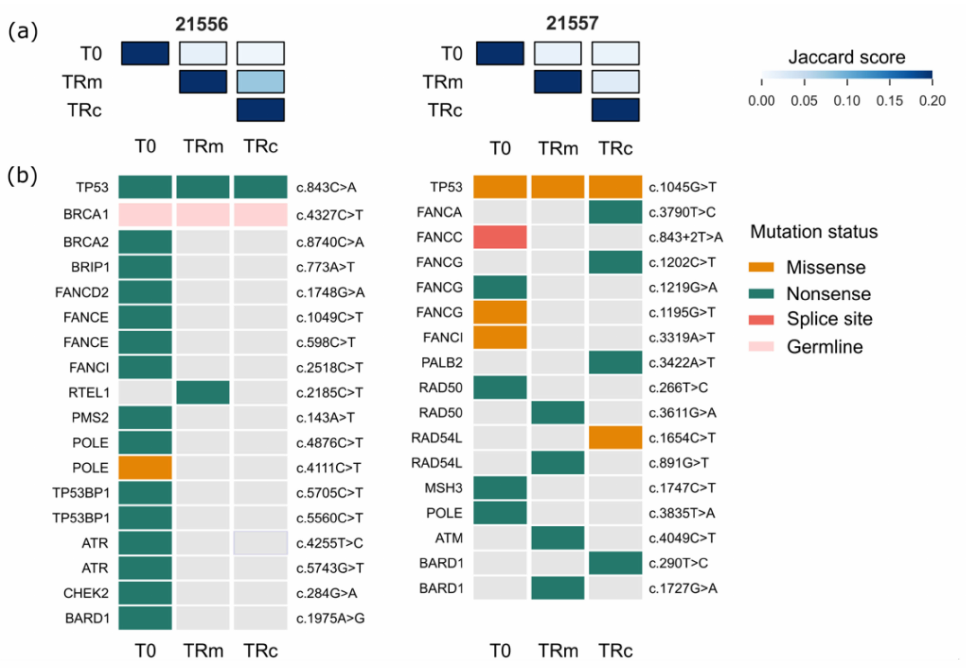
Figure 3. Genomic landscape evolution of SNVs in plasma samples. Jaccard similarity score ( a ) and oncoprints of pathogenic variants ( b ) for two representative cases (namely, 21556 and 21557) are reported. ( a ) The Jaccard similarity score is a numeric value indicating the level of similarity of sample pairs (see Section 2). Rows and columns report the name of the samples as in a square matrix (i.e., T0, TRm and TRc). The Jaccard score is reported in a blue color scale on the right side of the figure. The darker the color, the higher the similarity score, as reported in the legend (min = 0%, max = 20%). ( b ) Oncoprints show longitudinal evolution (i.e., T0, TRm and TRc) of pathogenic variants in each plasma sample. Variants are represented with the HGVS notation and referred to the genes reported on the left. The legend on the right depicts the different SNVs